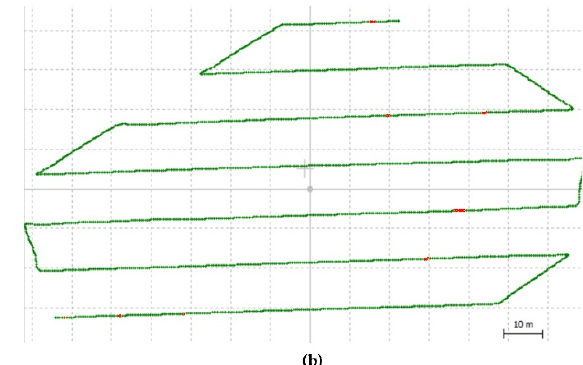
Figure 5 (b) An example of the plot derivable from RTKLIB processing. A successful computation. Green dots represented fixed GPS/GNSS solutions while red dots are float solutions.